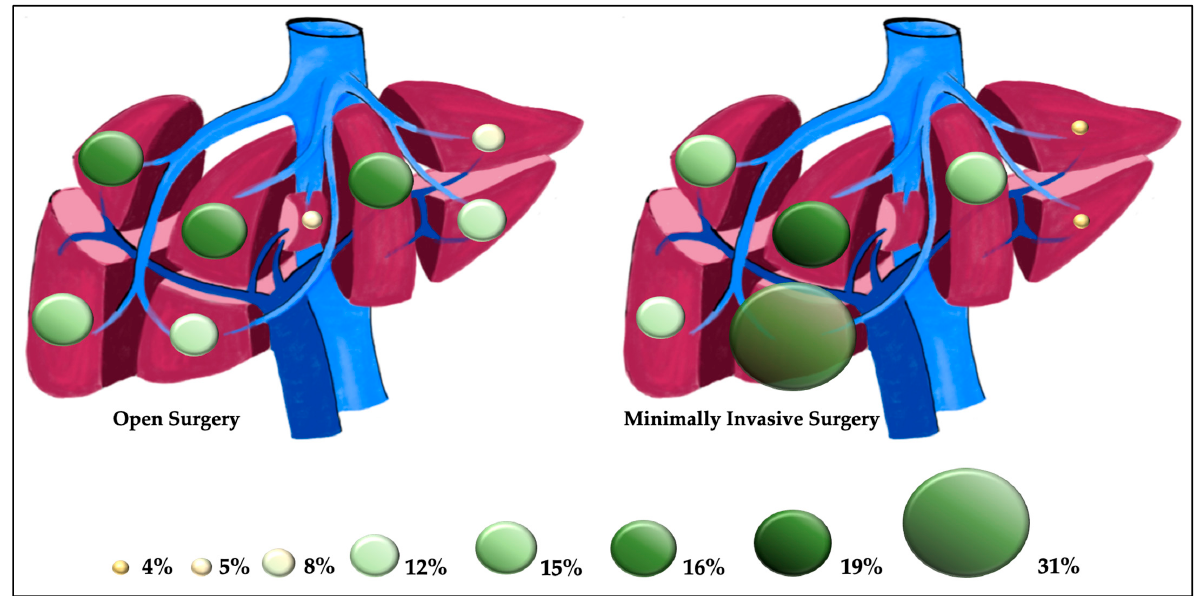
Figure 3. Proportional distribution of the metastasis for the two groups.